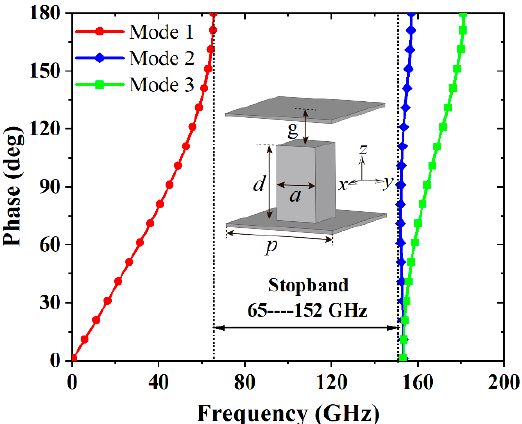
Figure 9. The geometry of the unit cell and its dispersion diagram (g = 0.2 mm, d = 0.7 mm, a = 0.4 mm, p = 1.1 mm).